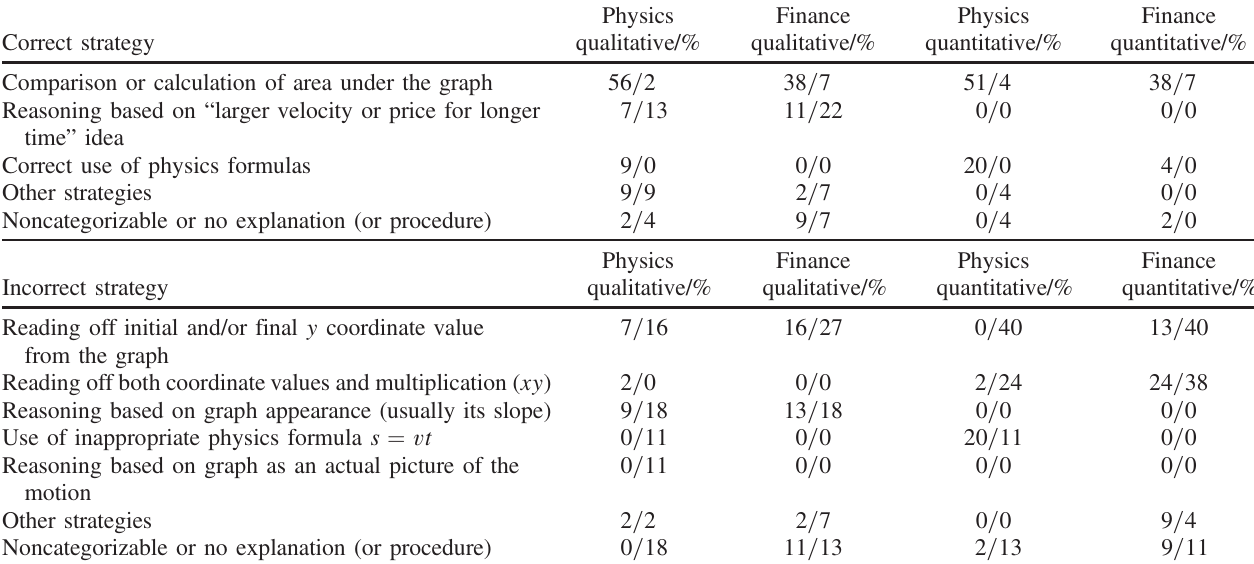
TABLE IV. An overview of strategies used by students for the area questions. The left numbers show percentages of physics students and the right numbers percentages of psychology students who used a particular strategy. Correct